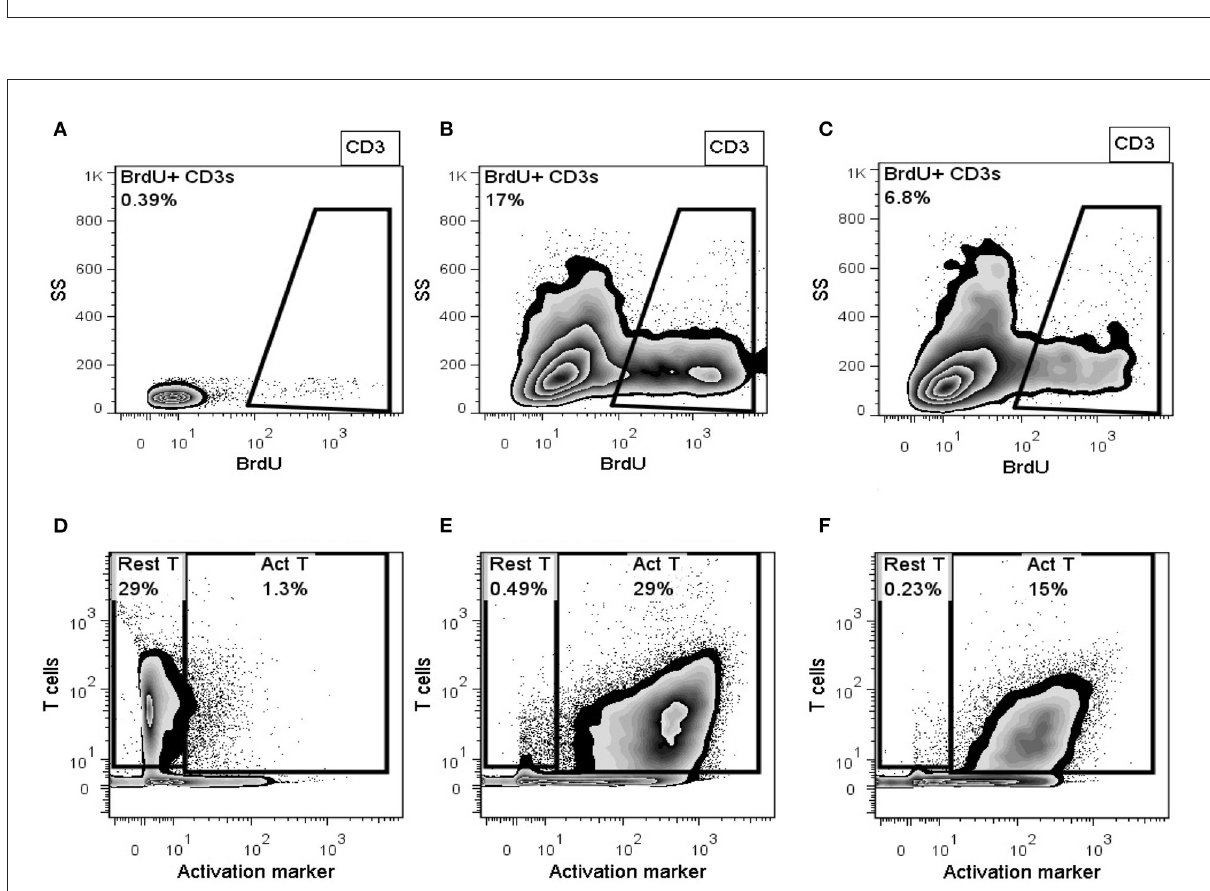
FIGURE3 Representative flowplots of proliferating T-lymphocytes (BrdU + CD3 + ) in PBMCs alone (A) , Concanavalin A-activated PBMCs (B) , activated PBMCs co-cultured with UMSCs (C) ; and representative flowplots of surface expression of T-cell activation marker in PBMCs alone (D) , Concanavalin A-activated PBMCs (E) , and activated PBMCs co-cultured with UMSCs (F)